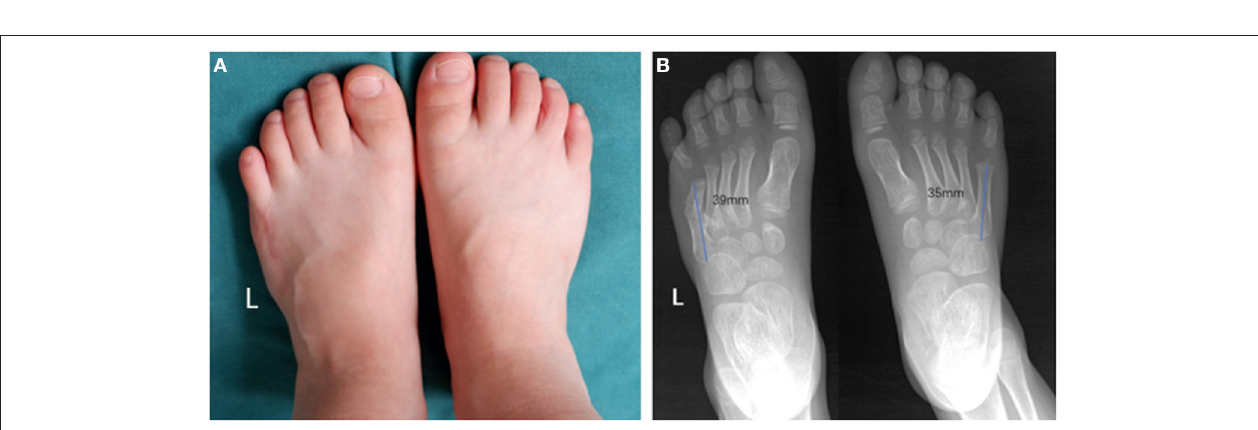
FIGURE 5 | Postoperative morphological and radiologic characteristic of feet. (A) The appearance of left foot recovered well 1-year after operation, and the length of the fifth toe was the same as that of the unimpaired side. (B) The fifth digit column of left foot was lengthened. The postoperative length of the fifth metatarsal in the left foot was 39mm and the fifth metatarsal in the right foot was